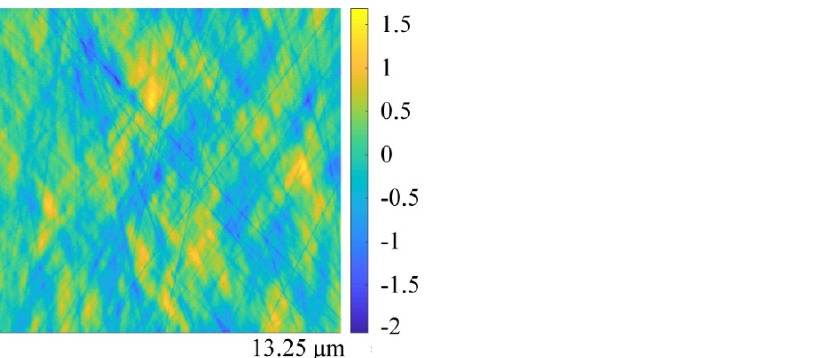
Figure 14. Simulated surface morphology for monocrystalline silicon with pure colloidal silica slurry within a 13.25 μ m × 13.25 μ m range for sufficient polishing iterations; the sampling points are 500 × 500 in the x–y direction.